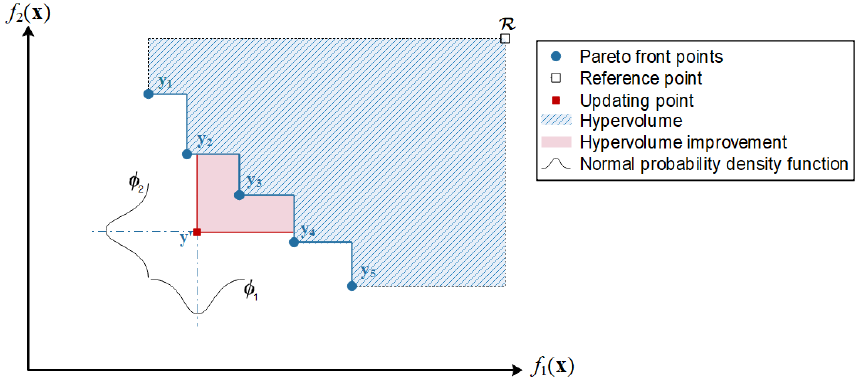
Figure 1. Example of a hypervolume indicator with two objectives